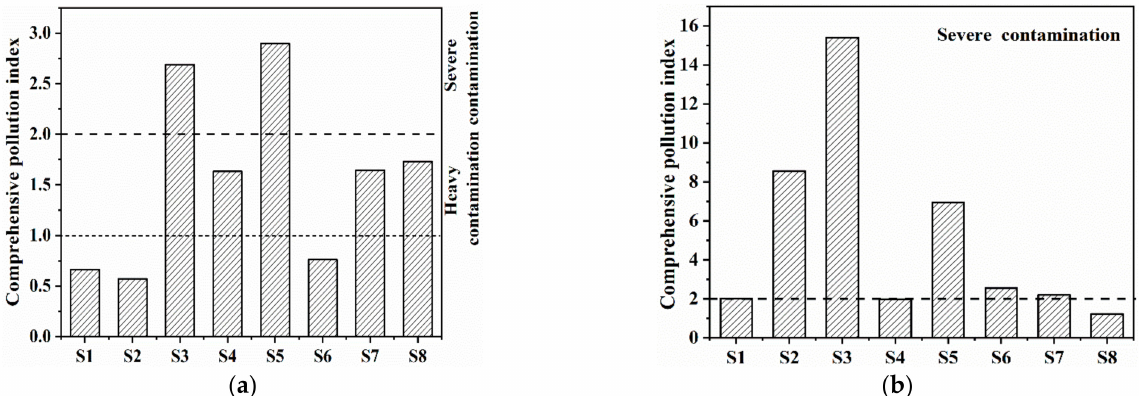
Figure 4. Evaluation of comprehensive pollution index of the Yitong River. ( a ) Overlying water, ( b ) Interstitial